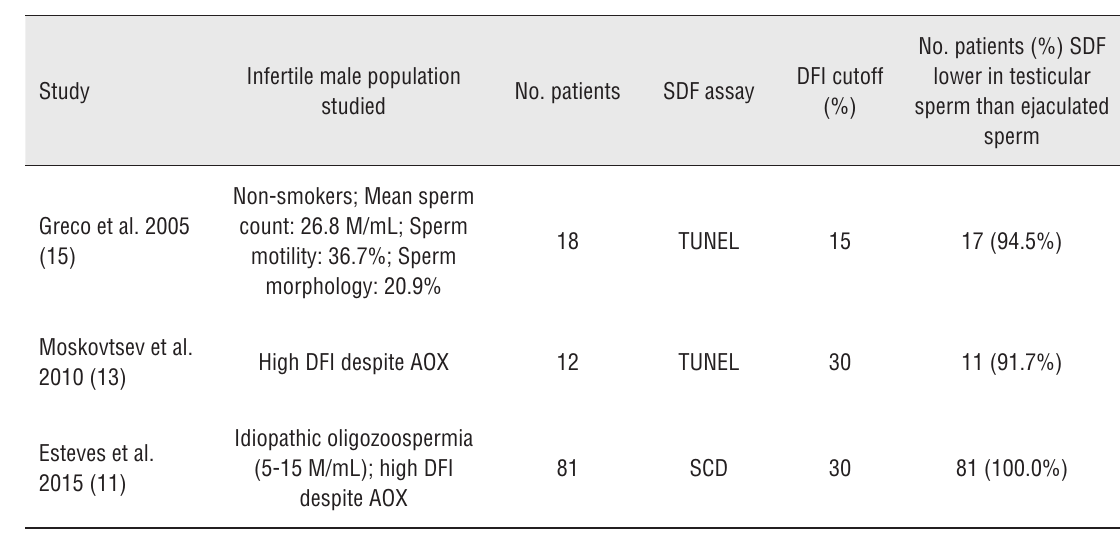
Table 1 - characteristics of studies comparing sperm DNA fragmentation rates between testicular and ejaculated sperm of the same men and how often SDf rates were lower in testis versus ejaculated sperm among men with high SDf in semen.